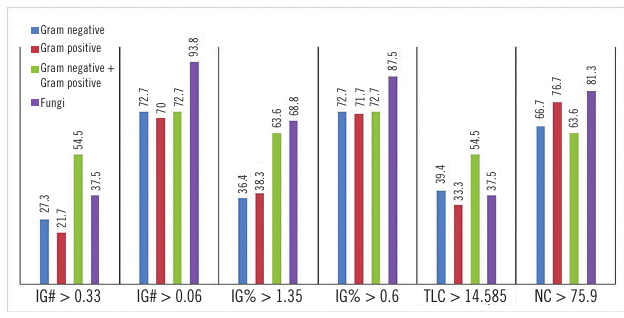
figurE 2 − Cut-off values of IG#, IG%, TLC and NC, and capture percentage by group of